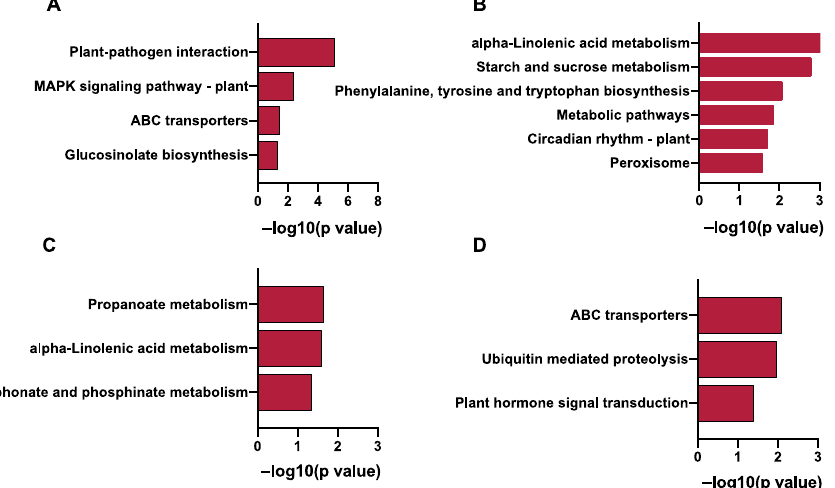
Figure 3. KEGG enrichment analysis of differential genes in PsnWRKY70 transgenic poplar. ( A ) KEGG enrichment analysis of uniquely upregulated genes in OE lines. ( B ) KEGG enrichment analysis of uniquely downregulated genes in OE lines. ( C ) KEGG enrichment analysis of uniquely upregulated genes in RE lines. ( D ) KEGG enrichment analysis of uniquely downregulated genes in OE lines.